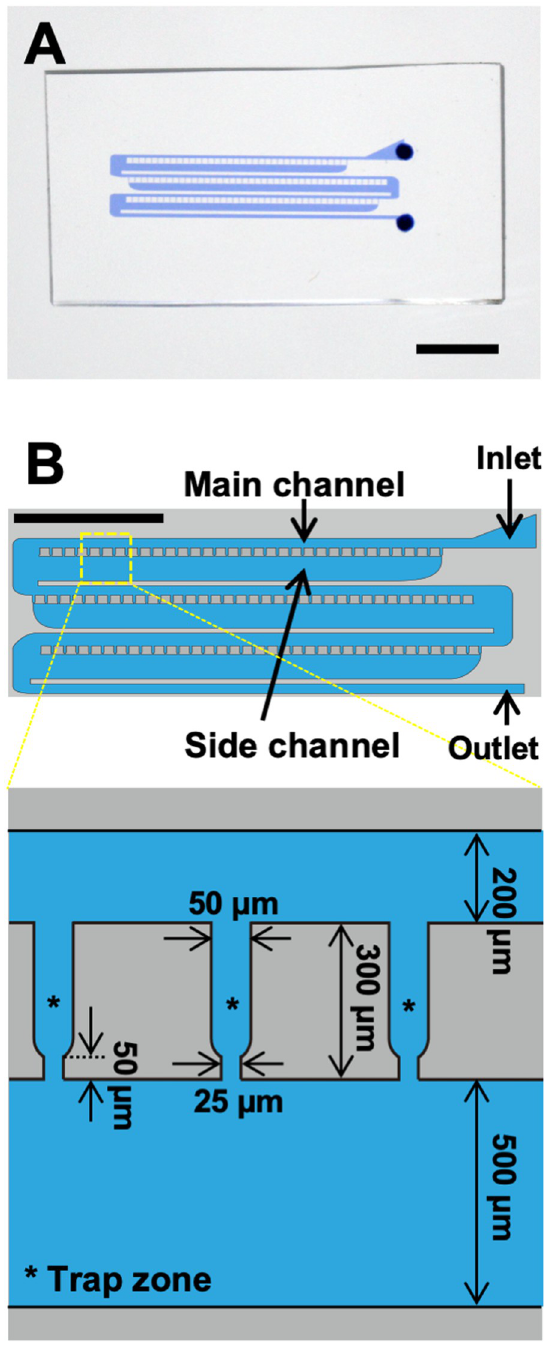
Fig 2. Design and fabrication of microfluidic device. (A) Fabricated microdevice with channels filled with blue- colored water. Scale bar, 5 mm. (B) Shape and size of microchannels. days to see whether they retained cell proliferation ability in the device. As shown in Fig 4A and 4B, the number of cells in the trapped single filament at the trap zone increased over time through cell division and the filament became longer. Observation of BY-2 cells expressing